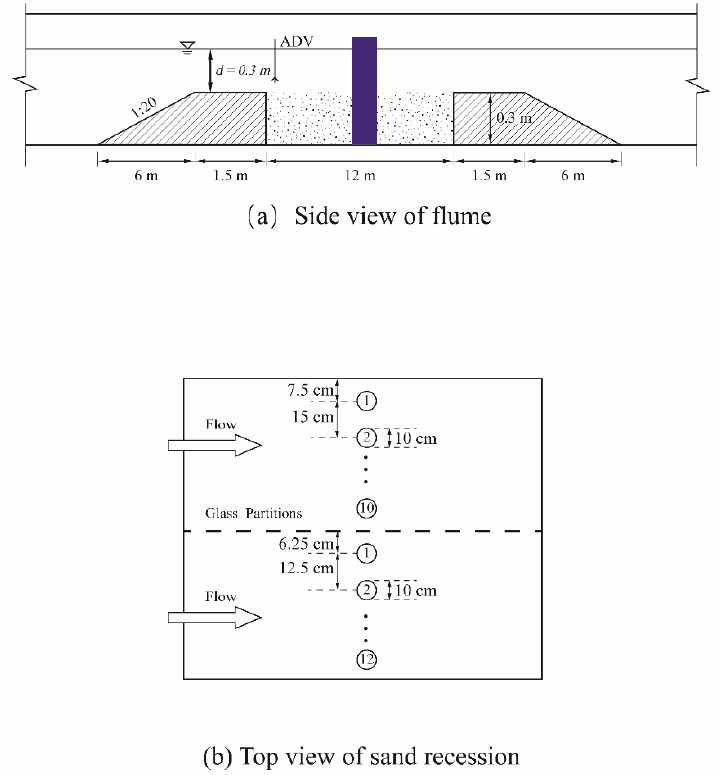
Figure 1. ( a ) Side view of flume and ( b ) Top view of sand recession, numbers 1,2, … 10, represent the marked number of piles in Experiment 2 and numbers 1,2, … 12, represent the marked number of piles in Experiment